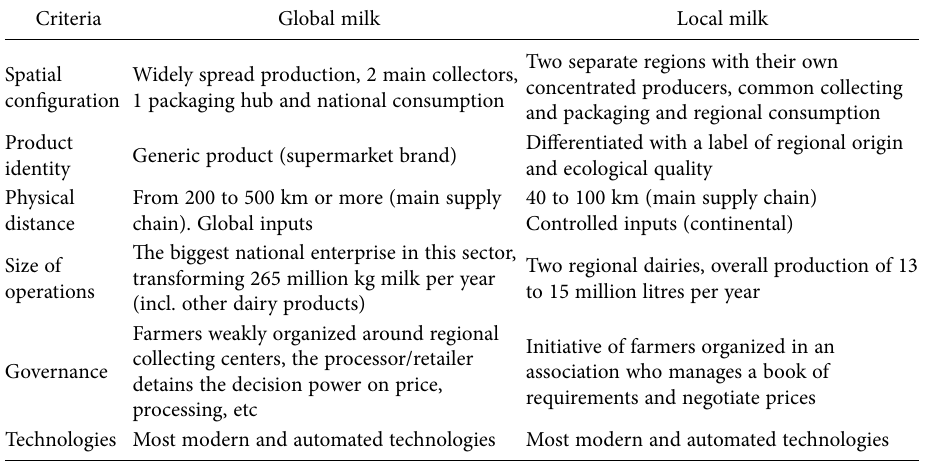
figure 3. On this chart the performance of the global chain has been artificially set to the middle of the scale (50%) and the performance of the local chain normalized to this score and limited between 0 and 100%. It can thus be seen in which indicators the local chain performs two times better or just slightly better, or worse than the global chain. We have set the global chain as reference because it is a conventional supermarket supply chain and the local chain is corresponding more to an alternative. On this radar, it is quite clear that the local chain is situated more at the outsides of the radar, thus showing higher performances. It is especially clear for the attributes transparency, soil preservation and food quality and safety. The local milk performs better for 6 attributes composed each by 2 to 4 indicators. It performs better in multiple dimensions like in the economic and social dimensions (value creation and distribution), in the environmental and health dimensions (climate change potential, biodiversity, soil preservation), and in the ethical and health dimensions (food quality and safety, and transparency).